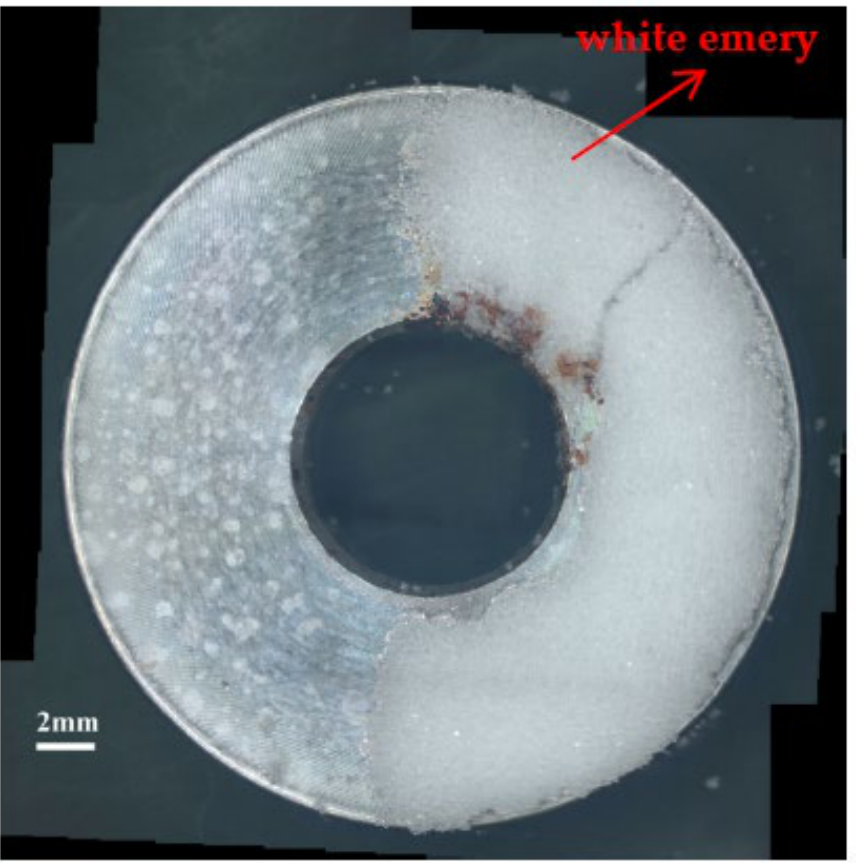
Figure 3. Macrographs of the specimens with a 1 g/m 2 chloride concentration after 7000 h of testing a relative humidity (RH) of 70%.